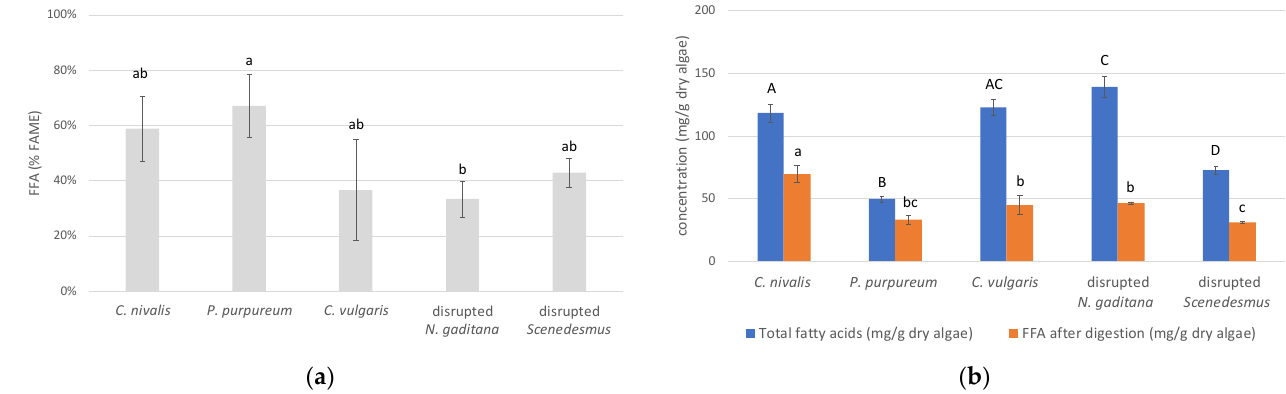
Figure 3. ( a ) Free fatty acids (FFAs) released from algae biomass after digestion, expressed as % of the total fatty acid content measured as fatty acid methyl esters (%FAMEs), and ( b ) expressed on dry algae basis. FFA levels within one graph are significantly different when they are not labeled with a common lowercase letter. Total fatty acid levels in the right graph are significantly different when they are not labeled with a common uppercase letter. A Tukey multiple comparison test was always used to compare values for different algae types.